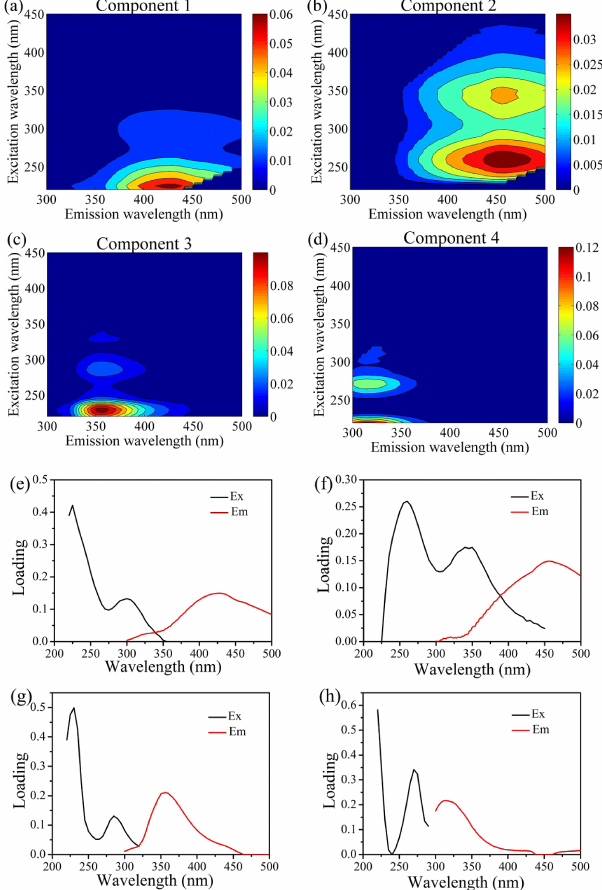
Figure 2. The PARAFAC modeling output shows the contour plots of the four PARAFAC fluorescent components (a–d) and excitation (black) and emission (red) loadings (e–h) of each component. Flu- orescence is in Raman units: nm − 1